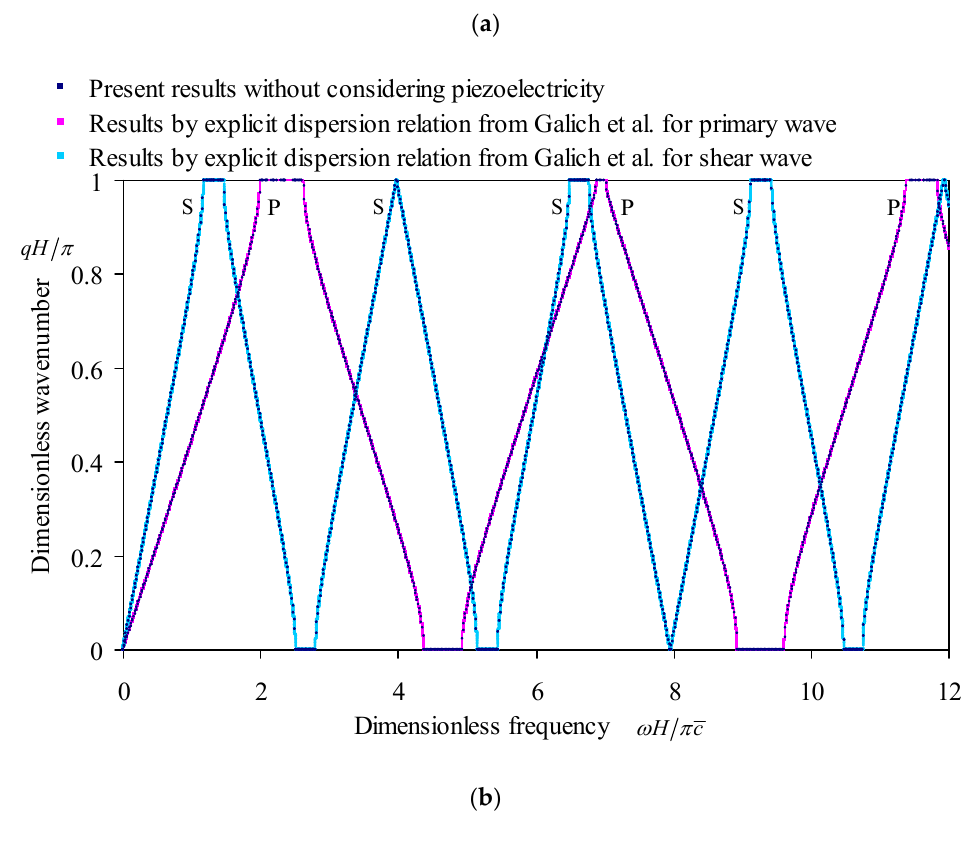
Figure 3. Comparisons of the wavenumber spectra of the exemplified periodic multilayers computed by the proposed method, by Kutsenko et al. [44], and by the explicit dispersion relation from Galich et al. [20], ( a ) in cases of the electric-open and the electric-short boundaries with reckoning on piezoelectricity; ( b ) in the case of the electric-open condition without considering piezoelectricity.